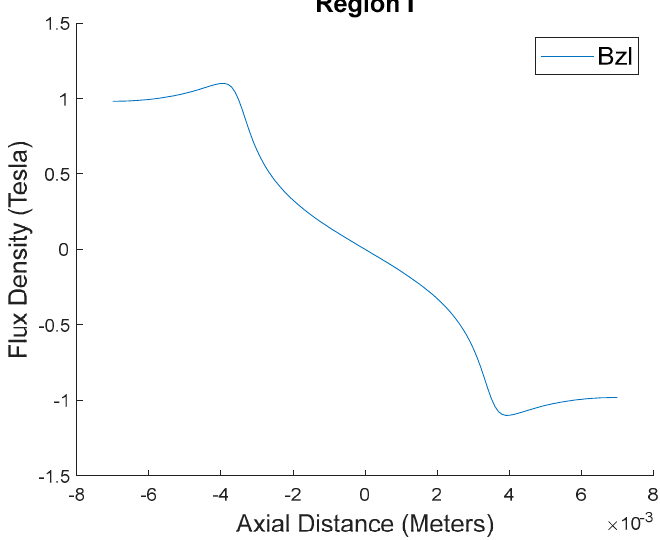
Figure 14. Radial flux density as a function of axial distance—Calculated using (18b).